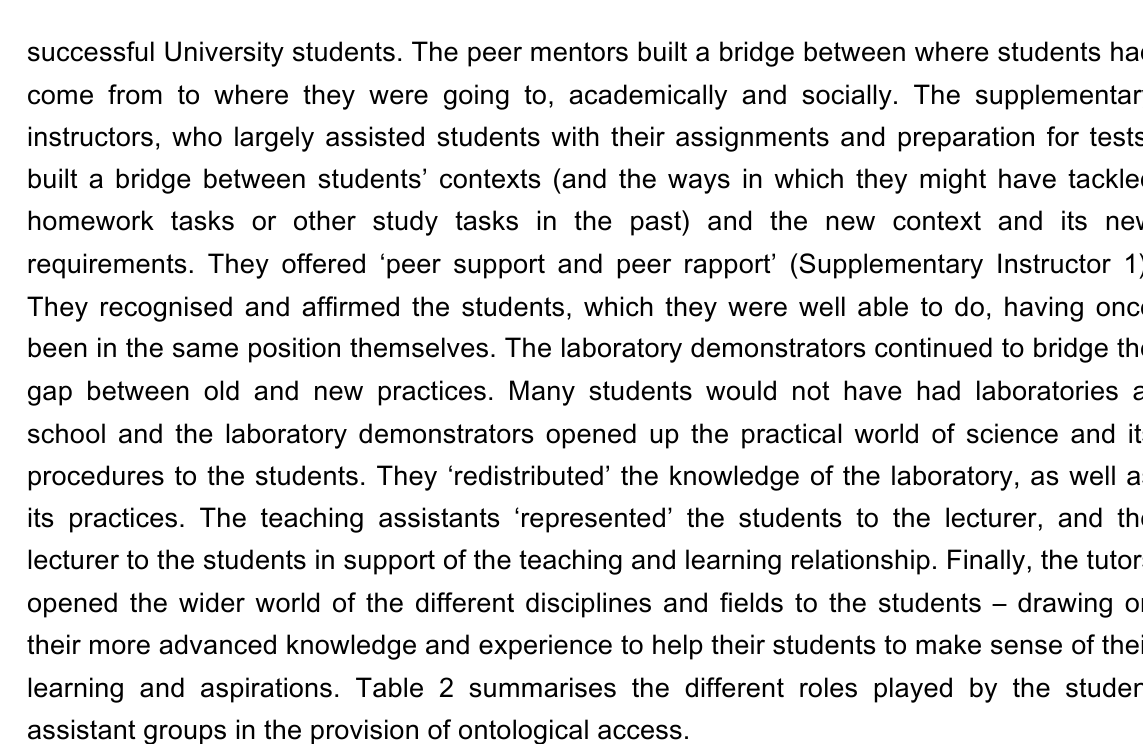
Table 2: Peer Educators’ Roles in the Provision of Ontological Access Peer Ontological Educators